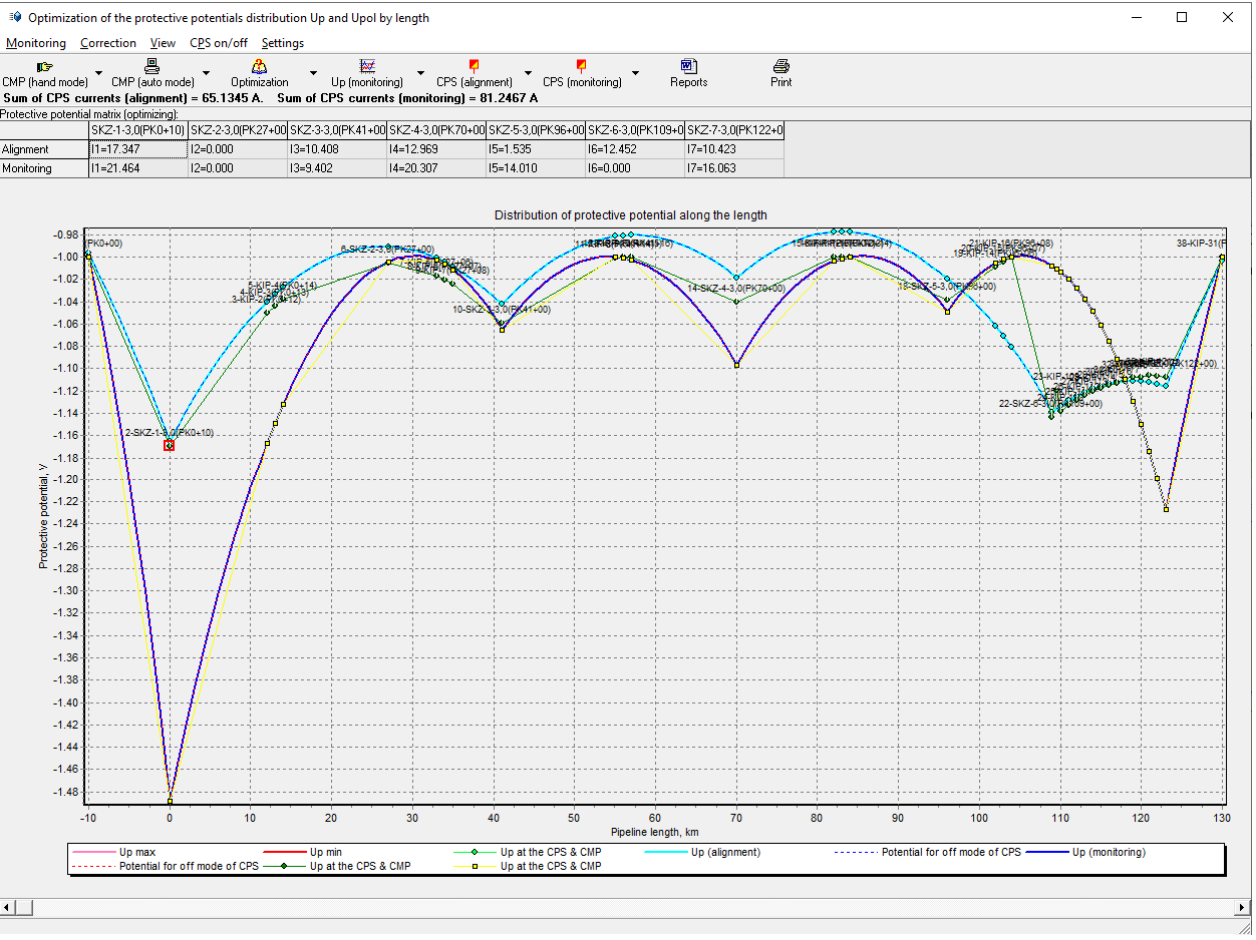
Figure 8. Plan for the intermediate distribution of the total potential along the section under consid- eration while minimizing the total current of all CPSs.